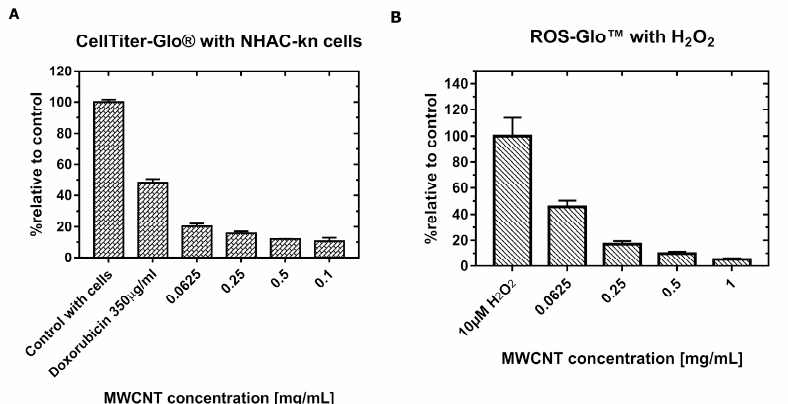
Figure 5. The plots represent the relative production of reactive oxygen species (ROS) in NHAC-kn cells after 48 h incubation with MWCNT-Ox ( A ) and signal of luminescence measured with the same concentrations of H 2 O 2 and various concentrations of MWCNTs-Ox ( B ). A strong decrease in the luminescent signal is visible with increasing amounts of carbon nanotubes.